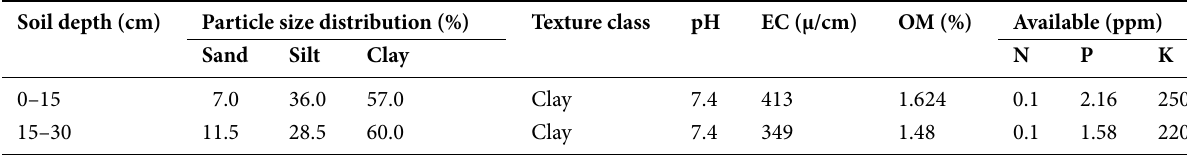
Table 1 Physicochemical properties of the experimental field soil including particle size distribution, texture class, pH, electroconductivity (EC), total organic matter (OM) and nitrogen, phosphorous, potassium (NPK). Soil depth